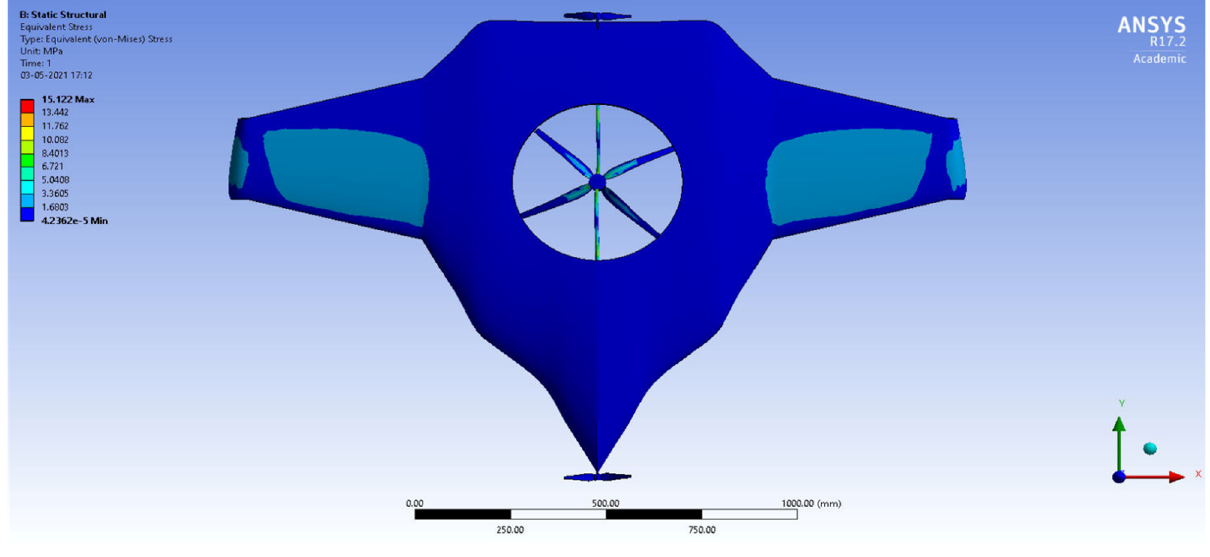
Figure 15. Equivalent stress.